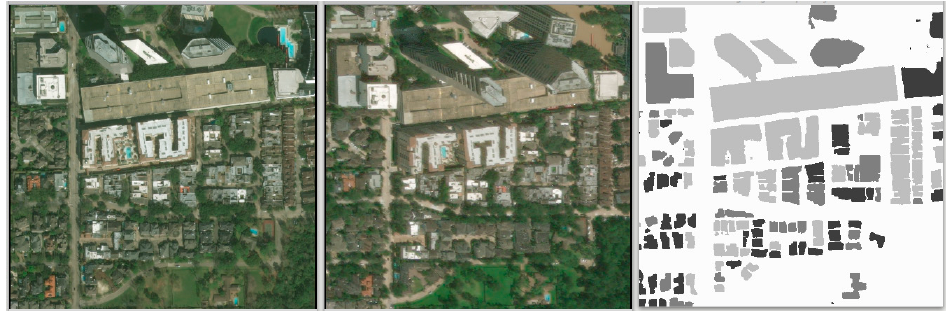
Figure 2. From left to right: The before-disaster, after-disaster, and damage magnitude inference images from our pipeline.